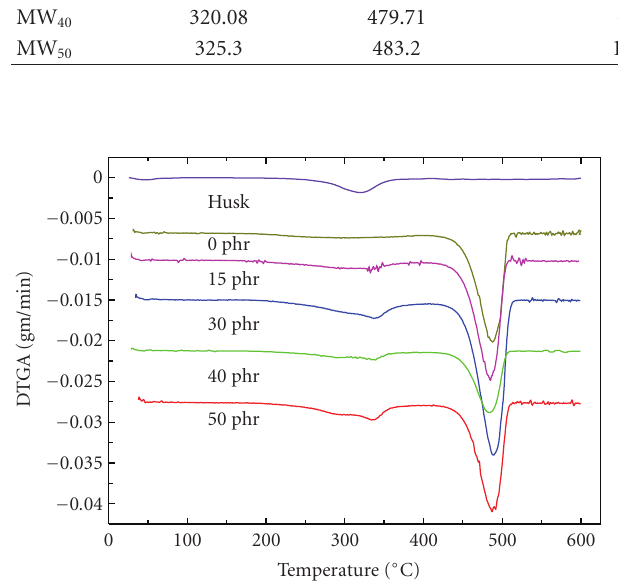
Figure 5: DTGA curves of WHF and WHF-EPDM